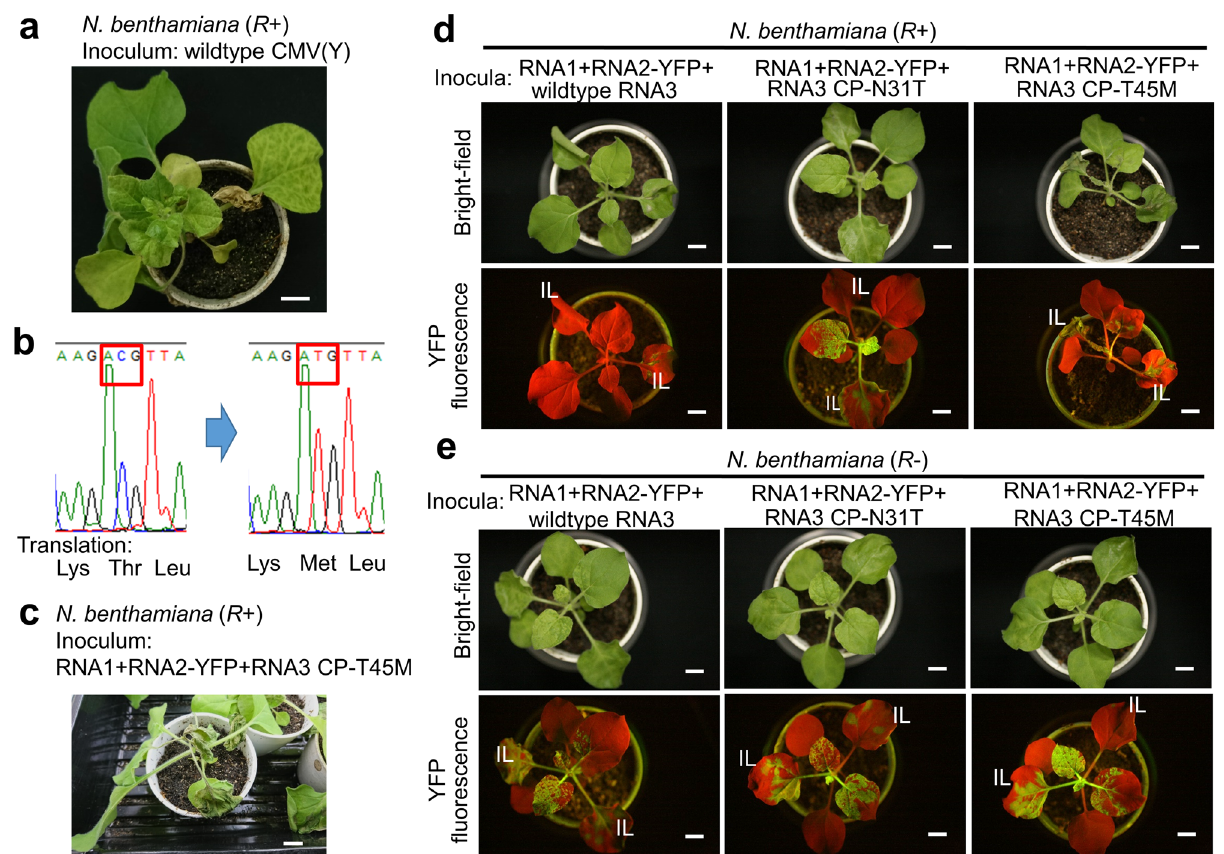
Fig. 2 Characterization of a CP-T45M variant in N. benthamiana . a Mosaic and necrotic symptoms appeared in upper uninoculated leaves of a N. benthamiana ( R + ) plant inoculated with wild-type (WT) CMV(Y) at 2 weeks after inoculation. b Sequence chromatograms for direct sequencing of reverse-transcription polymerase chain reaction (RT-PCR) product from WT and variant-infected plants. c An example of systemic necrosis observed at 1 week after inoculation of an RNA3 CP-T45M variant together with RNA1 and RNA2-YFP. d , e Representative images of bright- fi eld and YFP- fl uorescence observations of N. benthamiana ( R + ) plants d and N. benthamiana ( R – ) plants e at 4 days after inoculation of RNA1, RNA2-YFP, and WT RNA3 or CP variants. IL inoculated leaves. Note that uninfected regions of leaves appear red in YFP- fl uorescence observations due to auto fl uorescence; infected regions appear yellow. Scale bars = 1 cm. Similar results were observed in more than three replicates of experiments.